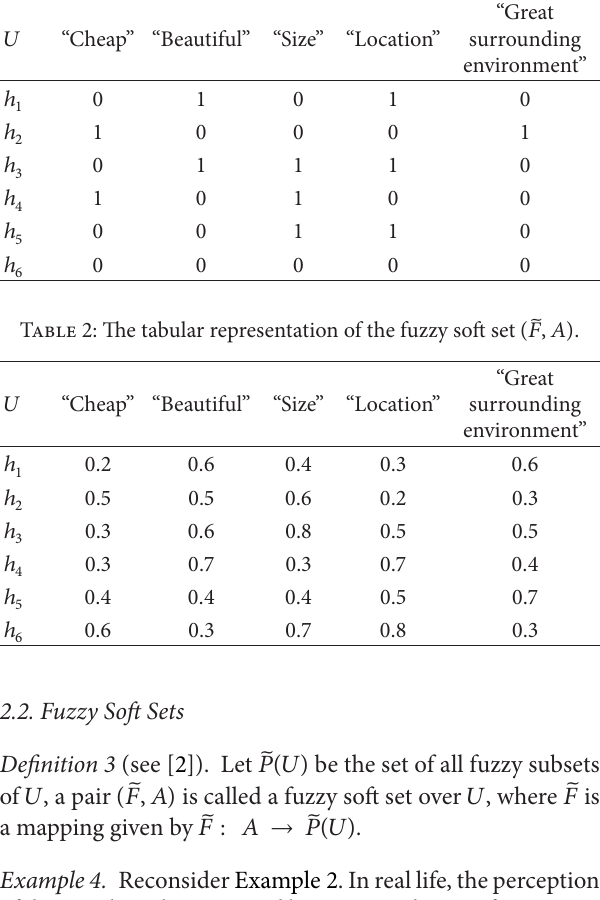
Table 1: The tabular representation of the soft set (𝐹, 𝐴) . 𝑈 “Cheap” “Beautiful” “Size” “Location”